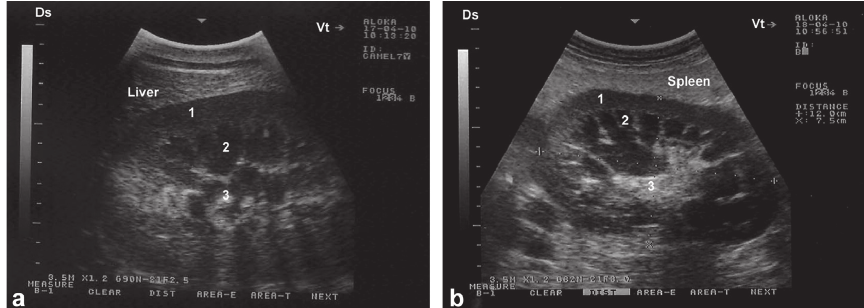
Figure 6: Ultrasonograms of a longitudinal section of the right (a) and left (b) kidneys in a healthy camel. Image (a) was taken from right 10th intercostal space through the so-called hepatic window. Image (b) was taken from the middle left flank through the so-called splenic window. 1, cortex; 2, medulla; 3, renal sinus’ DS, dorsal; VT, ventral.